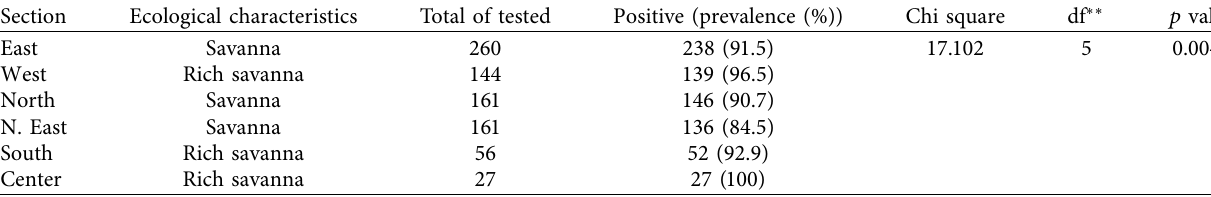
Table 1: The overall seroprevalence of BTV in different geographic areas in Kassala state.